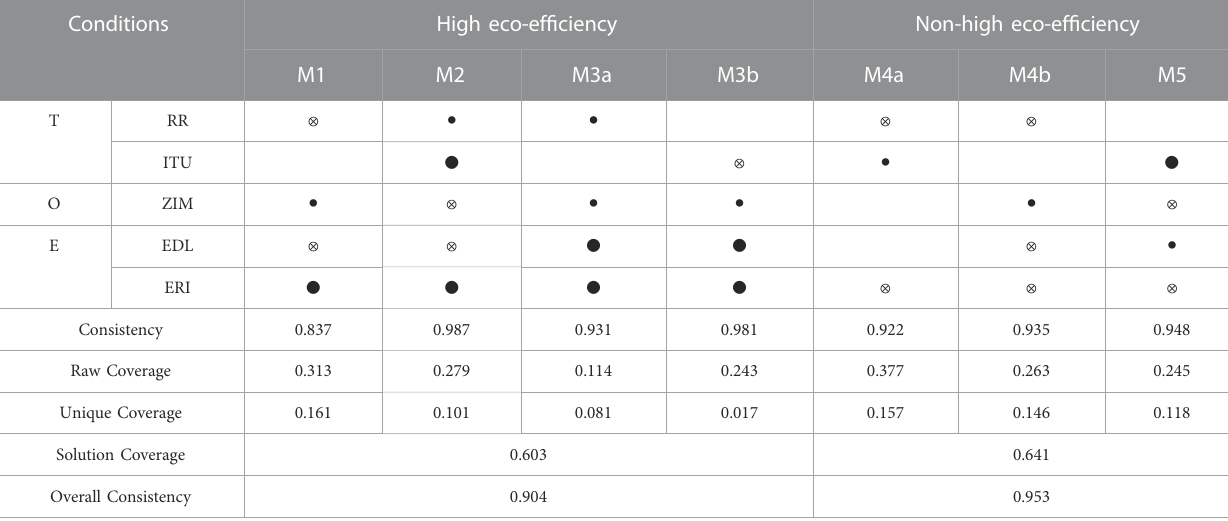
TABLE 4 Results of con fi gurational analysis.